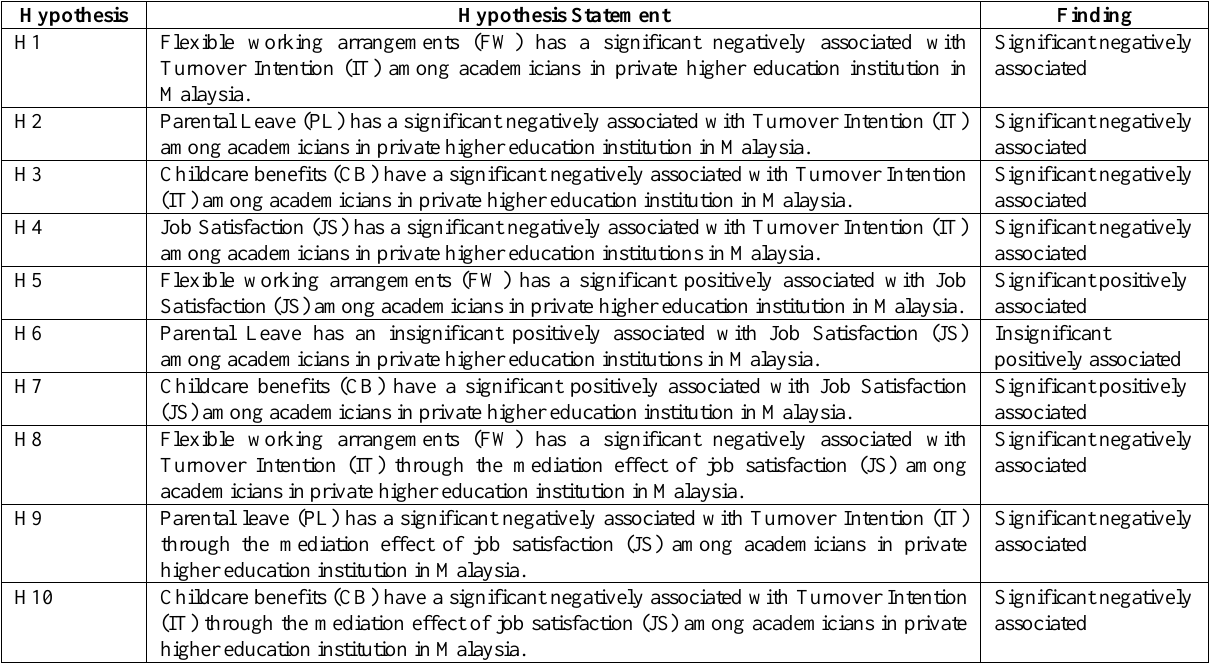
Table 6. Summary of Hypothesis